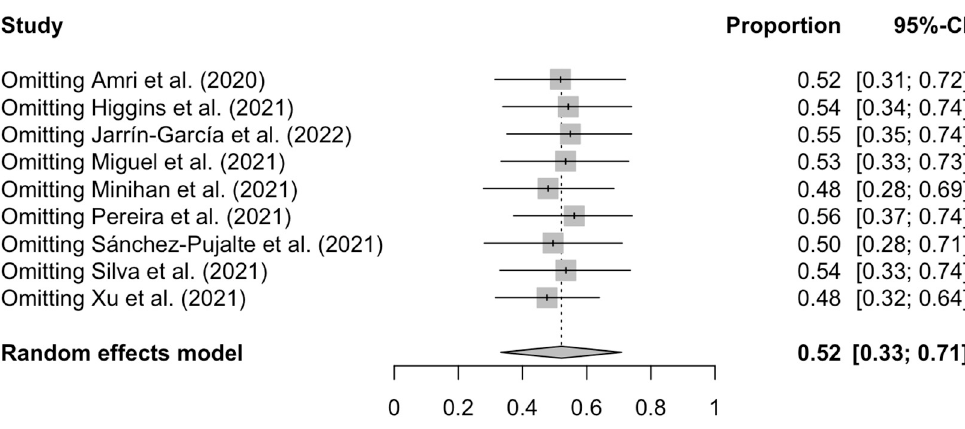
Figure 3. Sensitivity forest plot for the prevalence of burnout [40–48].